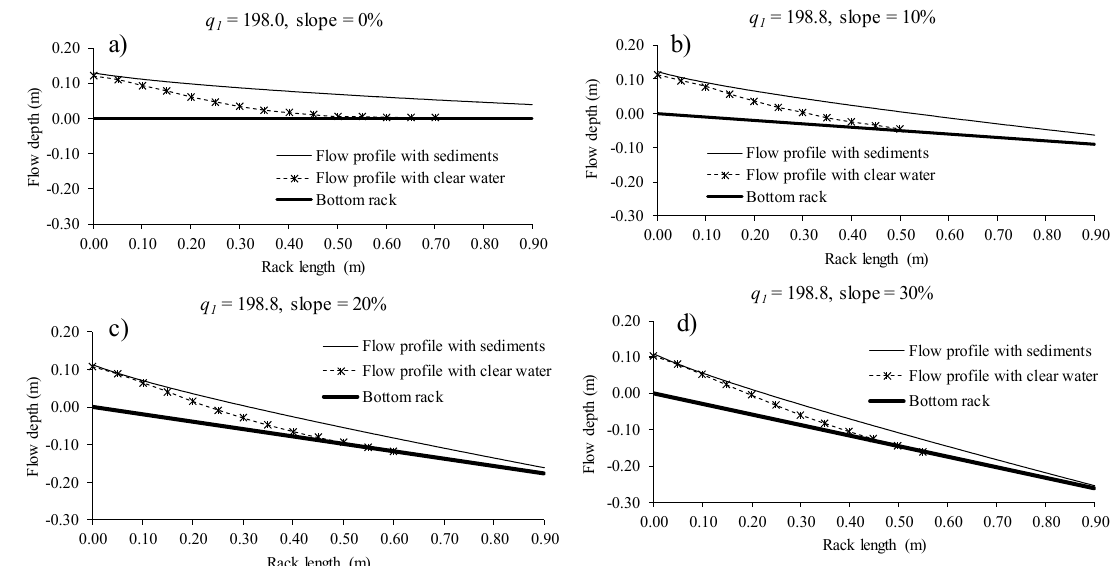
Figure 13. Water profiles over the rack measured in the laboratory and calculated for q 1 = 198.0 l/s/m and slopes ( a ) 0%; ( b ) 10%; ( c ) 20%; and ( d ) 30%.